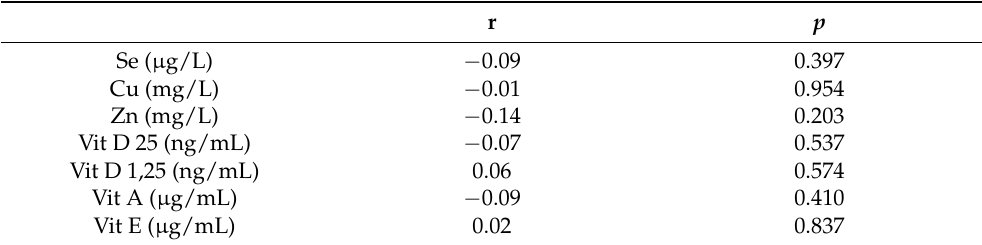
Table 4. Correlation between FEV1 and level of Zn, Se, Cu, vitamin D, vitamin A and vitamin